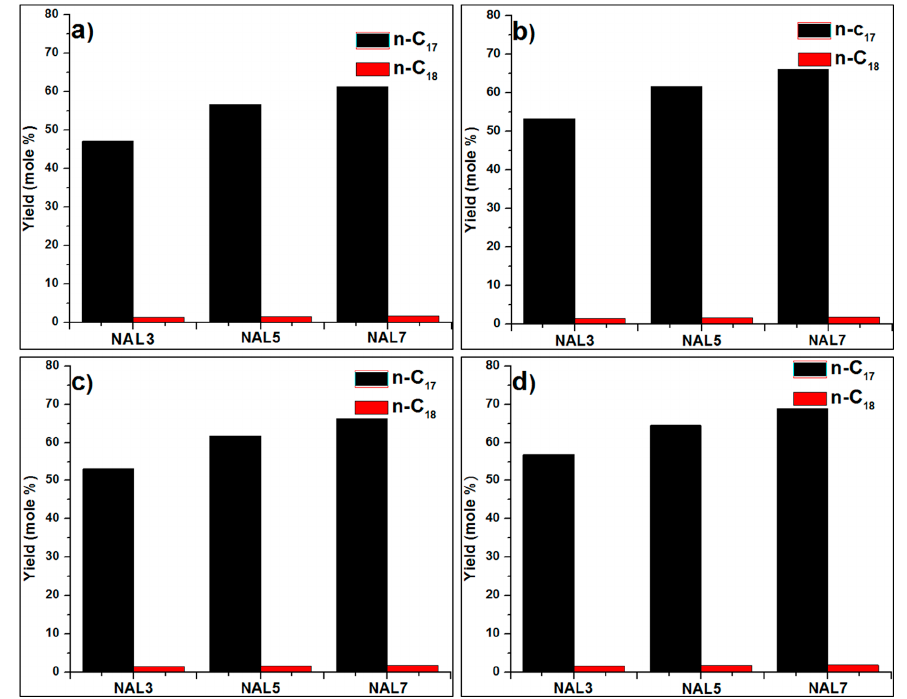
Figure 5. Yields of n ‐ C 17 and n ‐ C 18 from oleic acid hydrodeoxygenation on Ni/ γ‐ Al 2 O 3 catalysts: ( a ) 4 h, 320 °C; ( b ) 5 h, 320 °C; ( c ) 4 h, 340 °C; and ( d ) 5 h, 340 °C.